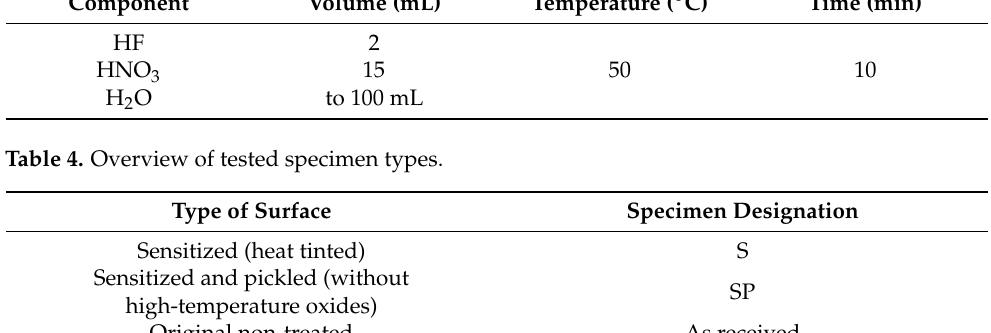
Table 3. Conditions of pickling [18].